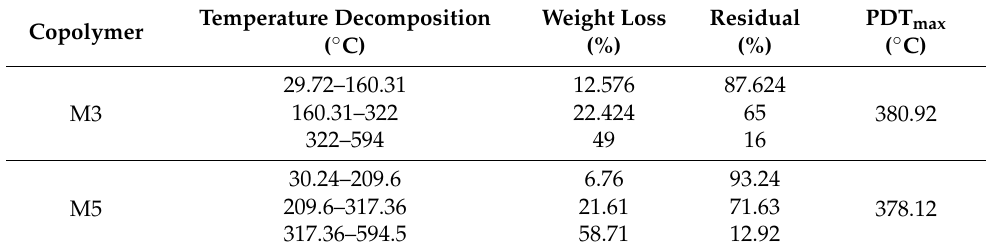
Figure 5. TGA curves of poly(DMA ‐ co ‐ AAc) hydrogel (( a ) for M3 and ( b ) for M5).